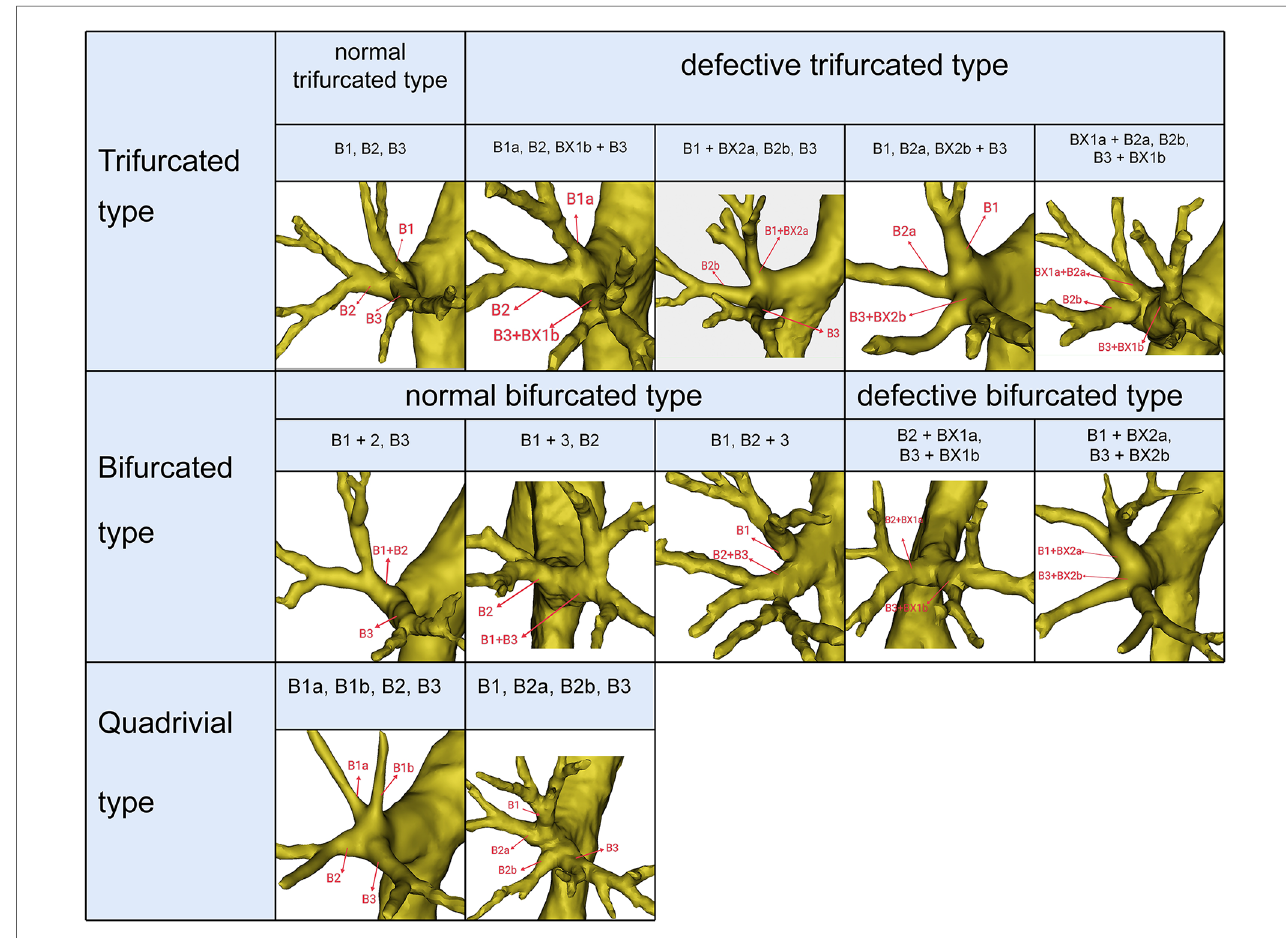
FIGURE 1 Trifurcated type, bifurcated type, and quadrivial type of RUL bronchus.